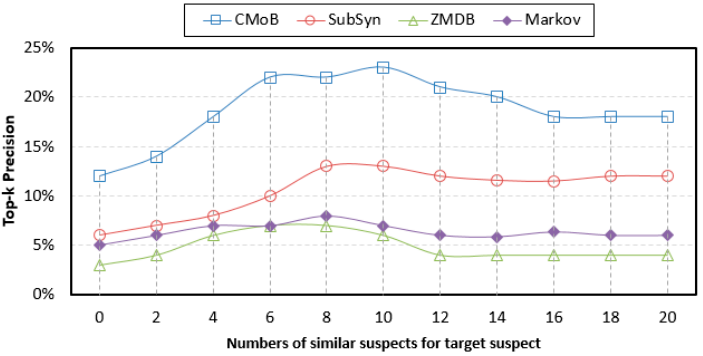
Figure 12. Top- k Precision.